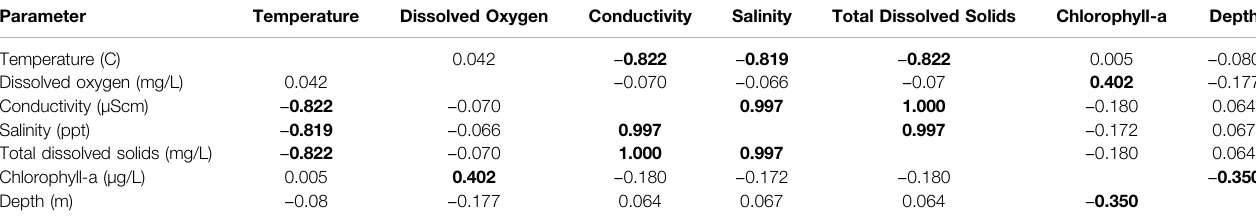
TABLE 1 | Correlation matrix for physical covariates measured at Mildred Island, within the Sacramento-San Joaquin River Delta, 26 July to 31 August 2018. Parameter